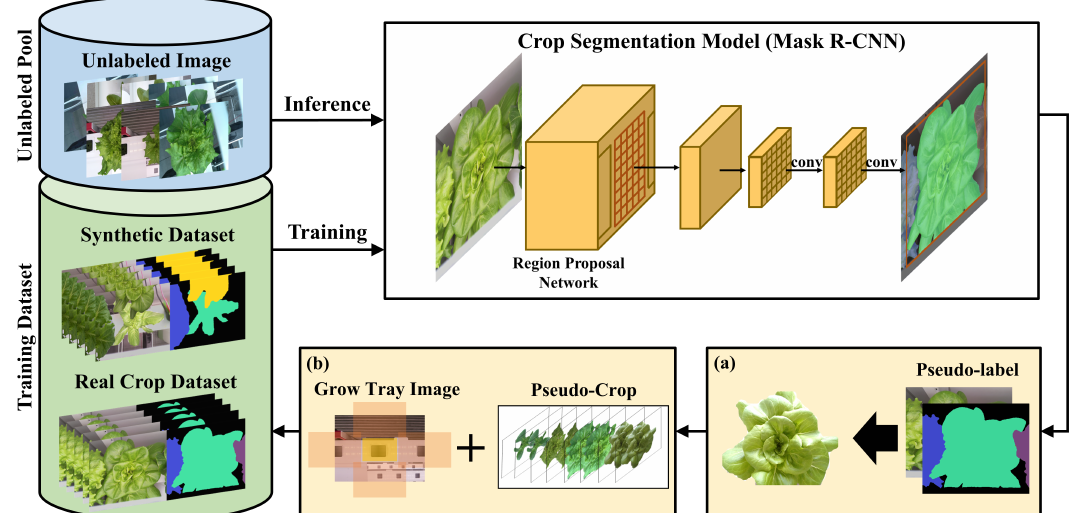
Figure 4. SC-Mix framework. Our method is composed of two modules: ( a ) pseudo-crop gen- eration (PCG) module generating the pseudo-crop with an unlabeled image. The PCG module converts only the pseudo-label for the monitored crop into the pseudo-crop, not the surrounding crop; ( b ) synthetic-image generation (SIG) module synthesizing the image taken on vertical farms using pseudo-crops. The synthetic images are combined with the training dataset to re-train the instance segmentation model of the